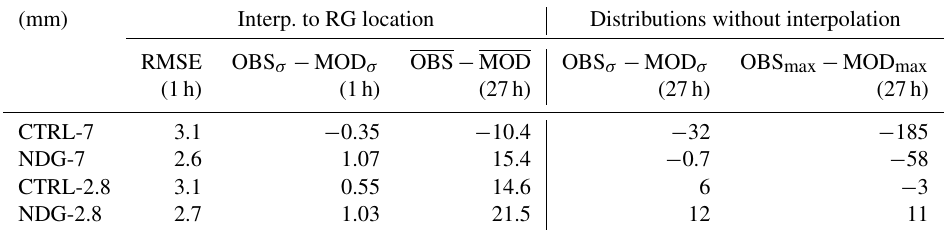
Table 2. Model precipitation validation against rain gauges (RGs). COSMO-CLM has been interpolated to the location of the RG for the first three metrics: root mean square error (RMSE), hourly standard deviation (SD) difference (OBS σ − MOD σ ) and spatially averaged differences (OBS − MOD). In contrast, all precipitation values simulated by COSMO-CLM over the island of Corsica are used in the last two metrics, SD difference (OBS σ − MOD σ ) and difference of maximum precipitation (OBS max − MOD max ). The temporal resolution of each metric is given in brackets. The description of the validation metrics can be found in the Appendix. (mm) Interp. to RG location Distributions without